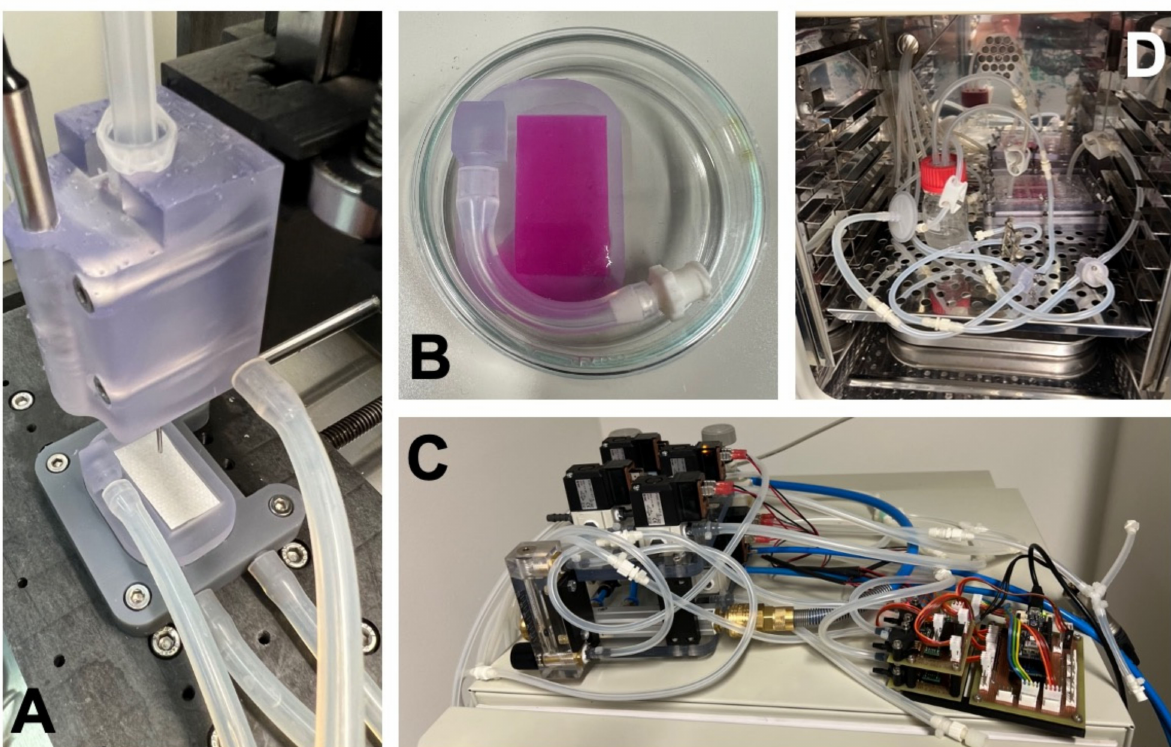
Figure 15. ( A ) A vacuum fixture with a decellularized pericardium installed in a bioprinter bed. ( B ) Upon completion of printing, the reservoir of the fixture is filled with a culture medium and placed into a Petri dish for the initial adhesion phase. ( C ) The stimulation and perfusion system. ( D ) Cell-seeded decellularized tissue installed in a bioreactor chamber for dynamic cultivation and